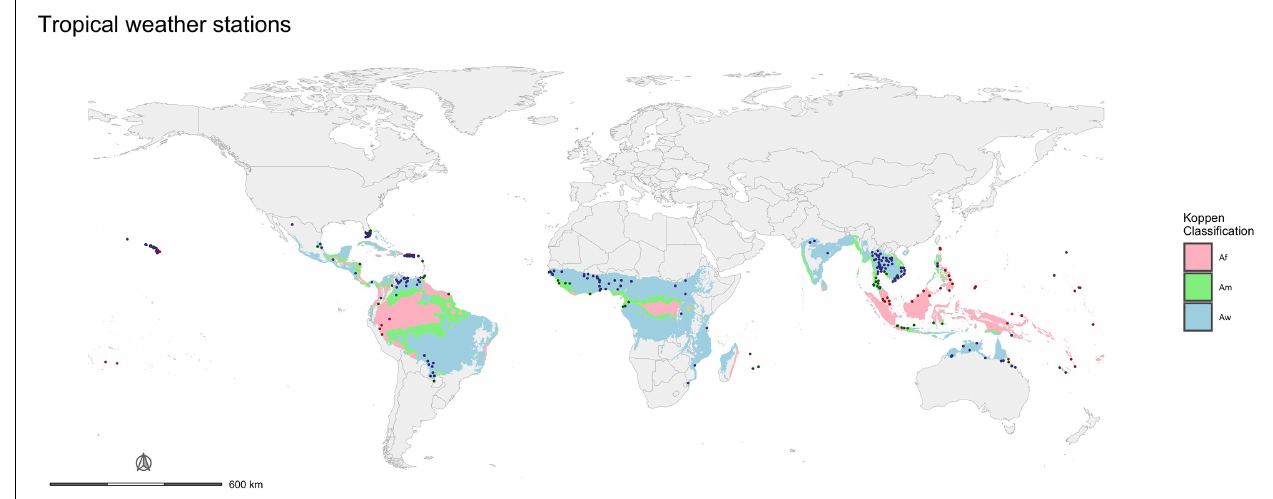
FIGURE 1 | Location of weather stations with maximum and minimum temperatures in tropical areas. The dots represent station locations and are color-coded by Köppen-Geiger classification. Data source: NOAA, GHCN.